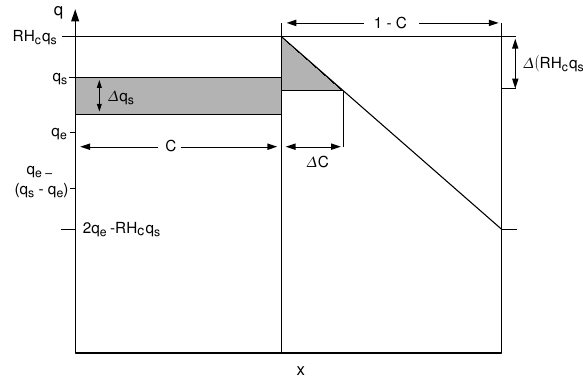
Fig. A1. Schematic: Partially cloud covered grid box with new cloud formation caused by a change in saturation vapor pressure ( 1q s ) and under certain conditions also critical relative humidity RH c (see text). C denotes the cloudy fraction and (1-C) the cloud free fraction of the grid box at the beginning of the time step. Spe- cific humidity ( q ) equals saturation specific humidity ( q s ) in the cloudy part of the grid box and is assumed to be uniformly dis- tributed around the environmental value q e in the cloud free part of the grid box (diagonal line). Shaded areas represent increases in condensate mixing ratio due to a change in q s . Adapted from Jakob